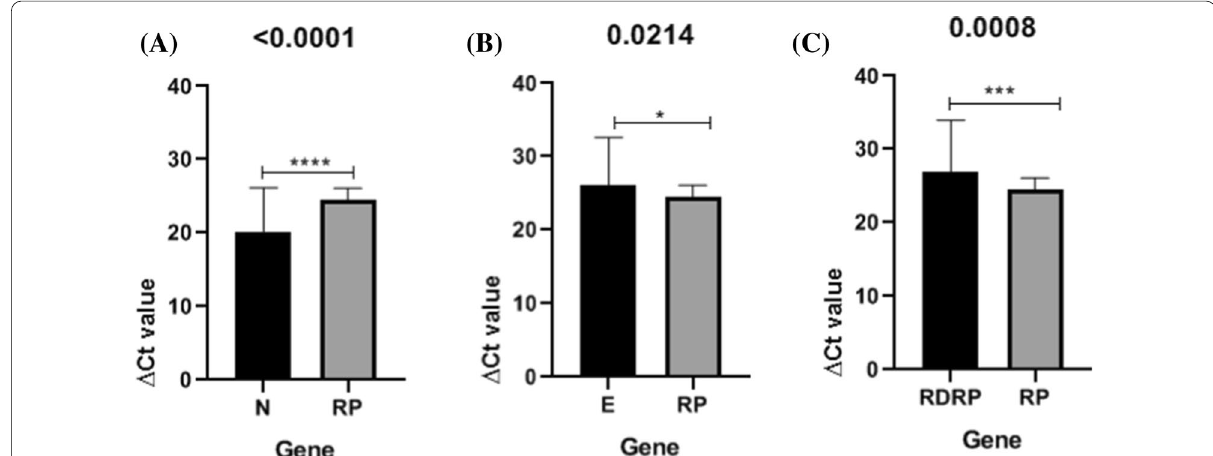
Fig. 3 Cycle threshold (Ct) value of qRT‑PCR. RP gene was used as an internal control. A Comparison of N target and RP, B Comparison of E target and RP, and C Comparison of RDRP target and RP. A significant difference is indicated by *P < 0.05. ****